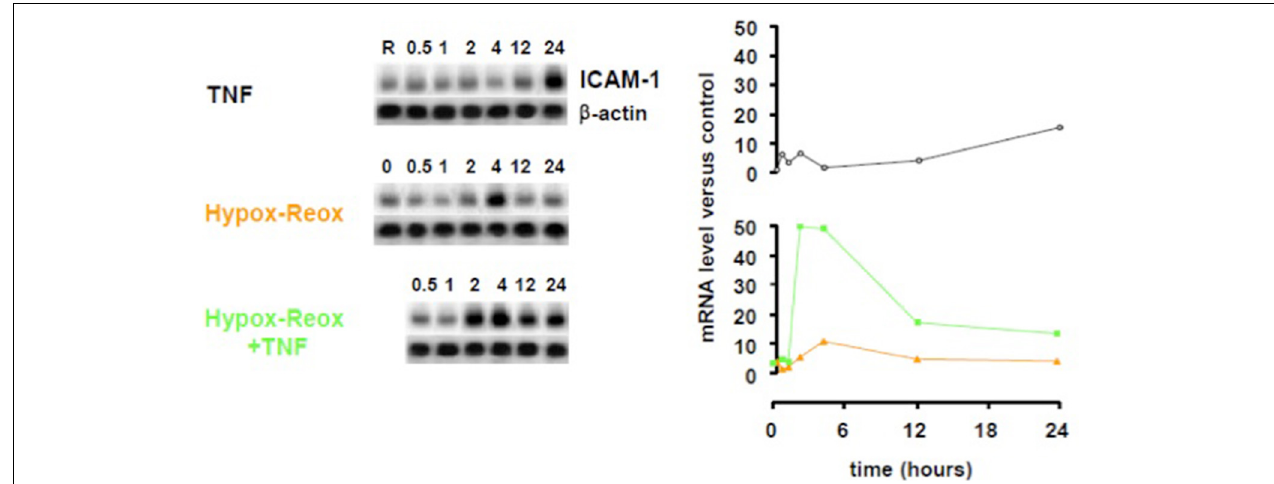
TNF and ICAM-1 mRNA was quantified at the designated time points using a PhosphorImager® SI (Molecular Dynamics). TNF, tumor necrosis factor; ICAM-1, intercellular cell adhesion